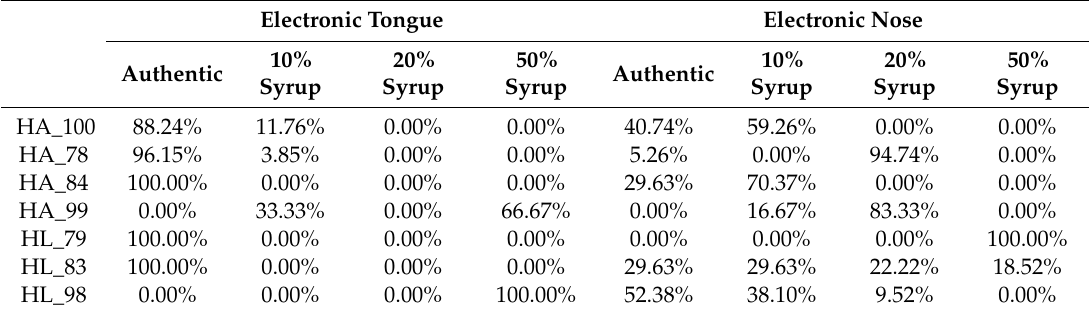
Table 5. Classification results of independent prediction of EUnonEU acacia and linden